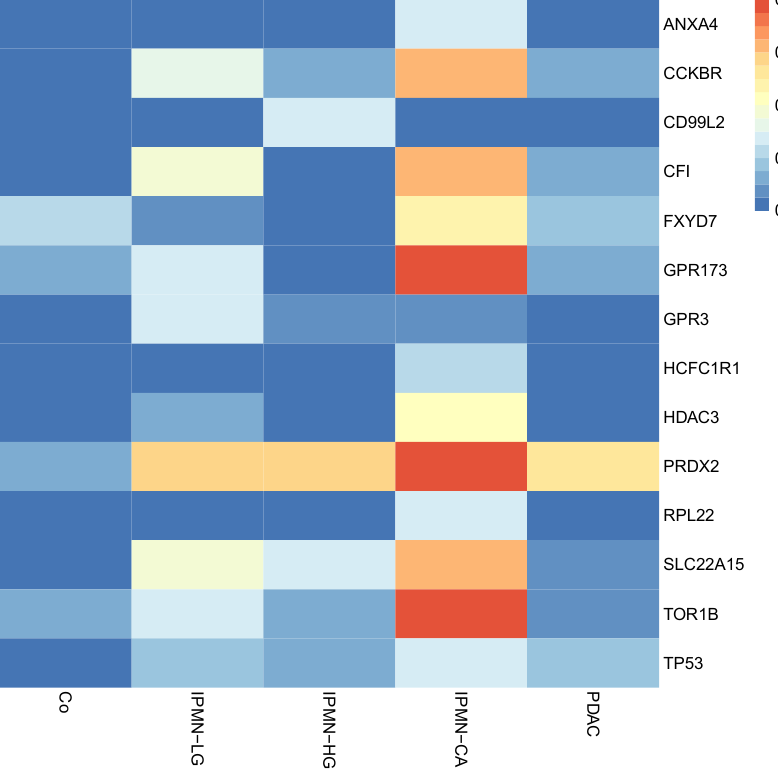
Figure 3. Heatmap of the proteins selected for disease discrimination and their proportion of reactivity among patients belonging to each disease class. Proteins are listed to the right of the heatmap. Each column represents a patient group.